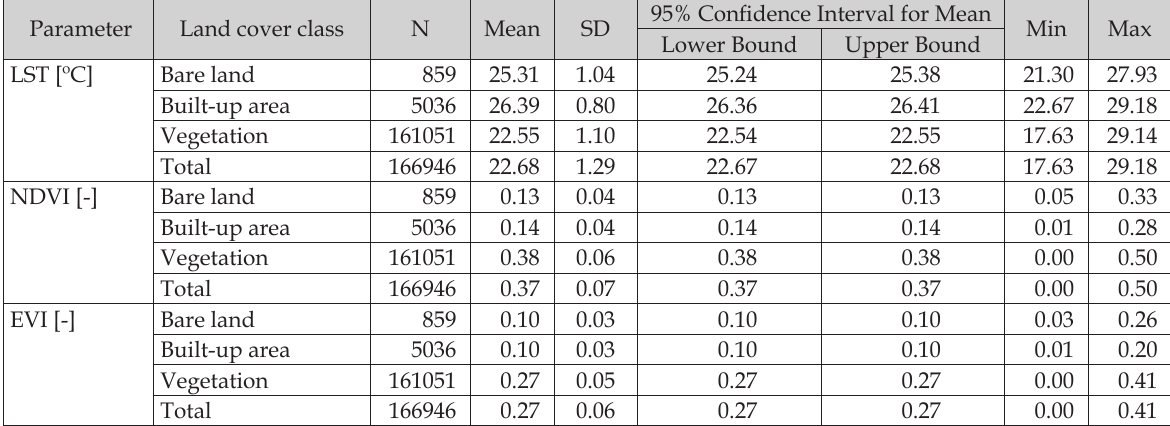
Table 5. Descriptive statistics of the LST, NDVI and EVI relationship with land cover in 1984.